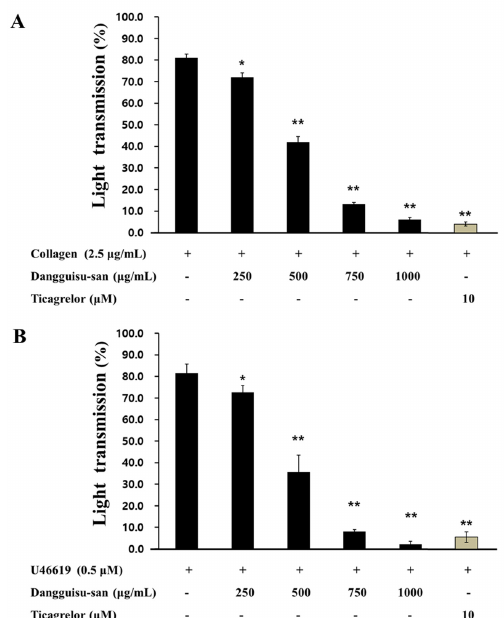
Figure 5. Effects of Dangguisu-san and positive control on agonist-induced platelet aggregation. ( A ) Effect of Dangguisu-san on collagen-induced human platelet aggregation ( B ) Effect of Dangguisu- san on U46619-induced human platelet aggregation. The results are shown as mean ± SD ( n = 4). * p < 0.05, ** p < 0.001 in comparison to the agonist-induced vehicle control. Plants 2023 , 12 , x FOR PEER REVIEW Table 4. Effects of four key components on TxA2 production in human platelets.